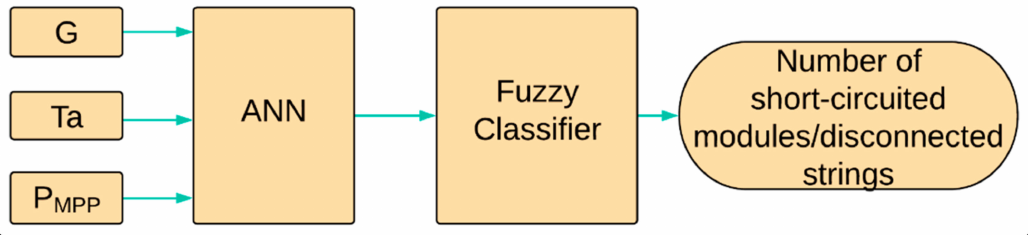
Figure 8. Fault detection method